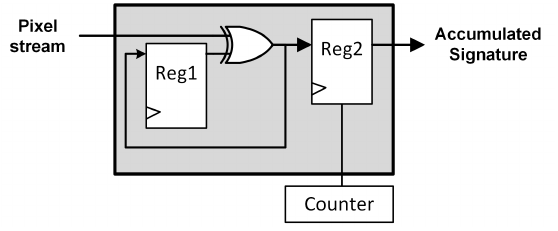
Figure 7. XOR-based signature generation module.